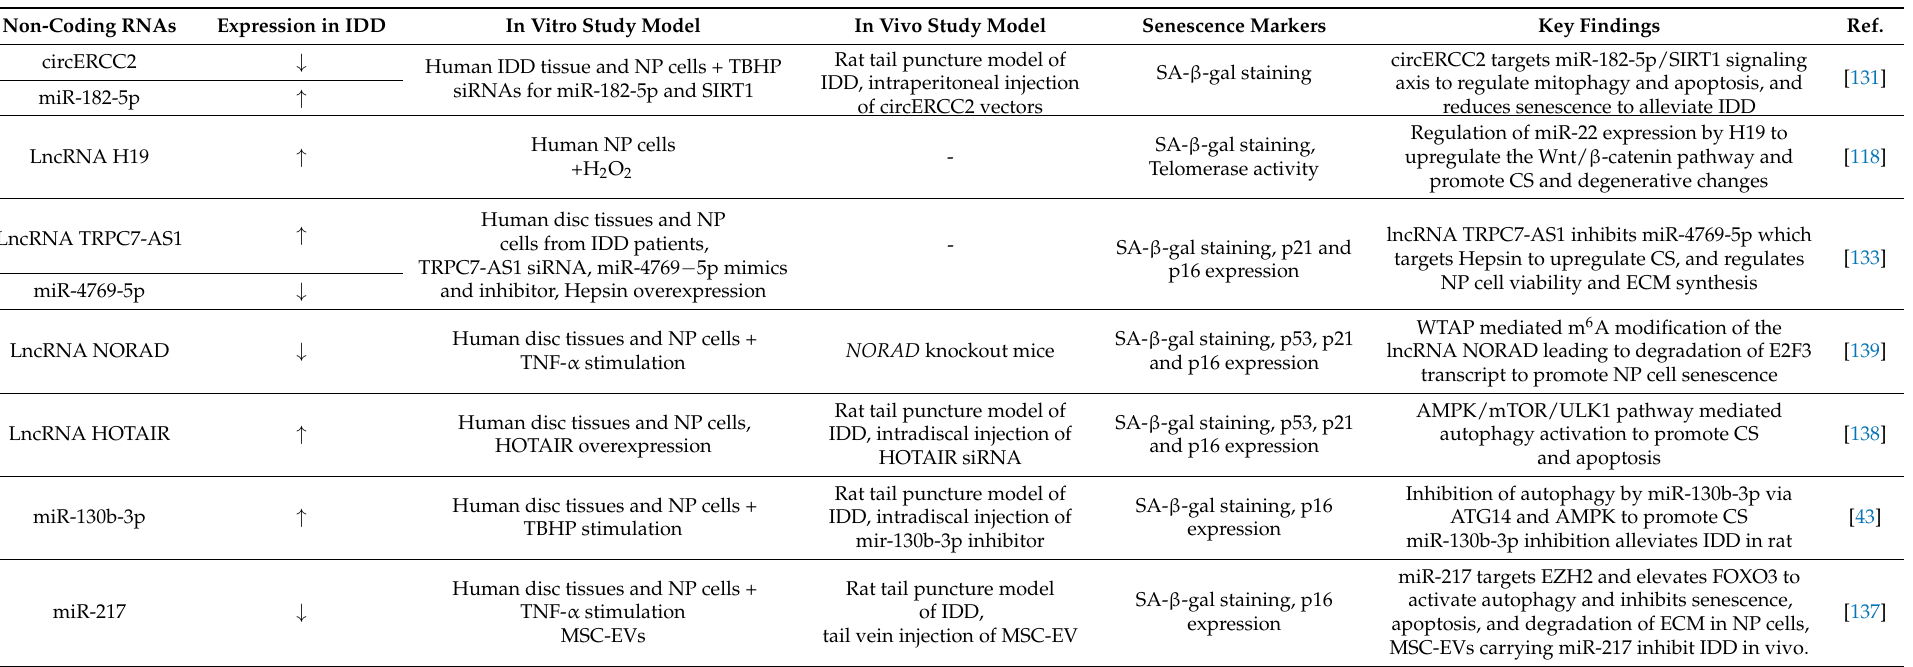
Table 1. Non-coding RNAs regulators of cellular senescence in intervertebral